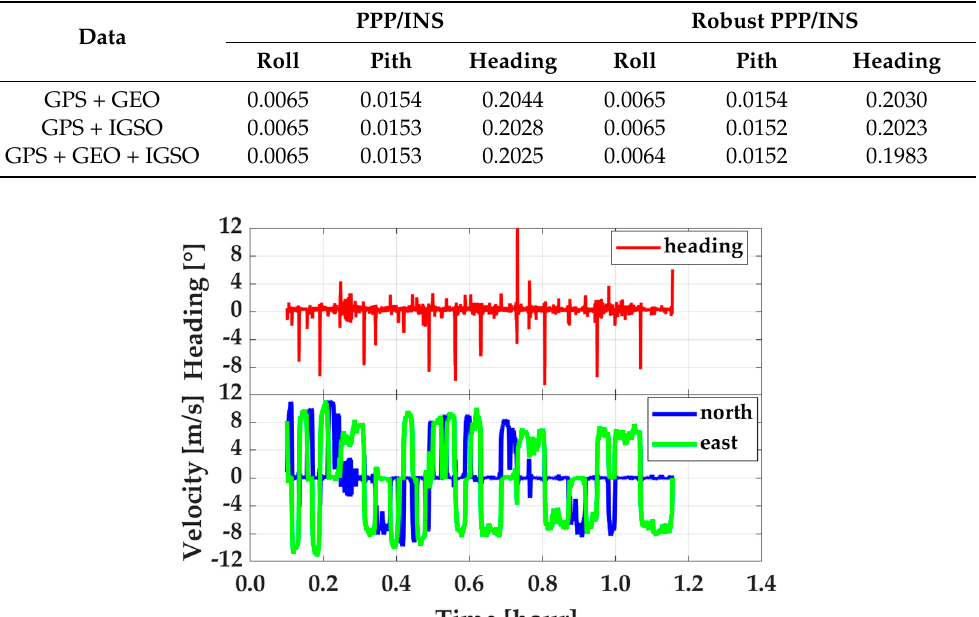
Table 5. Attitude RMS of PPP/INS tight integration with and without robust extended Kalman filter (unit: o ).